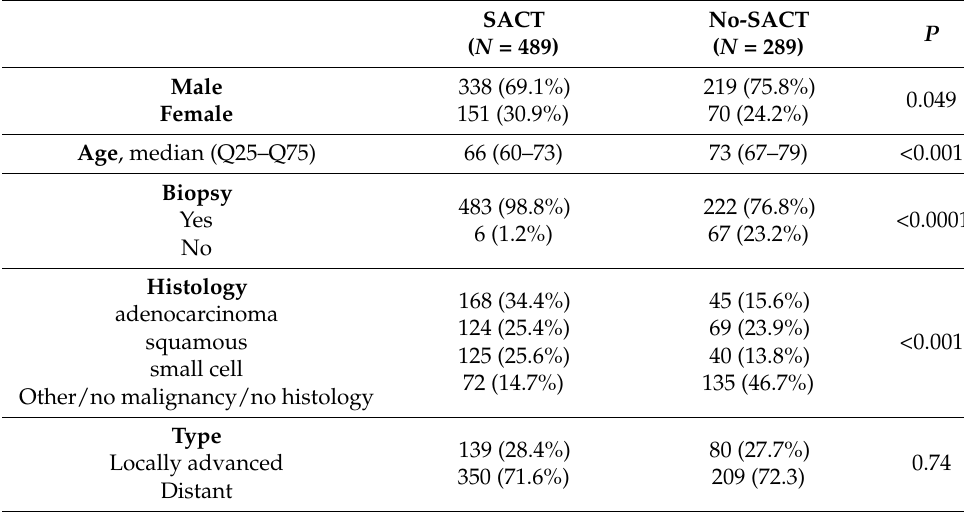
Table 1. Baseline and clinical characteristics of the study population.